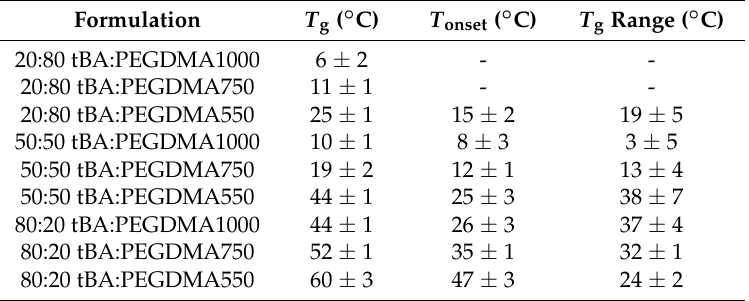
Table 1. T g , Tonset and T g range for SMP